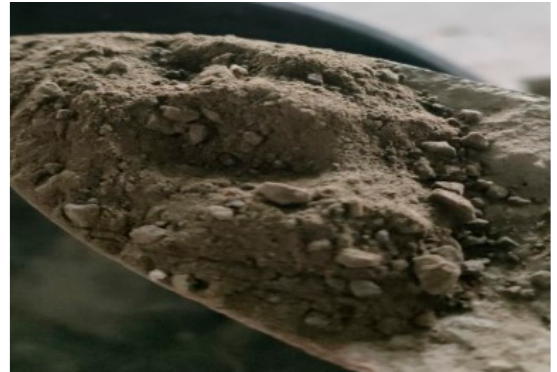
Figure 4. Crushed sand—alternate for fi ne aggregates.